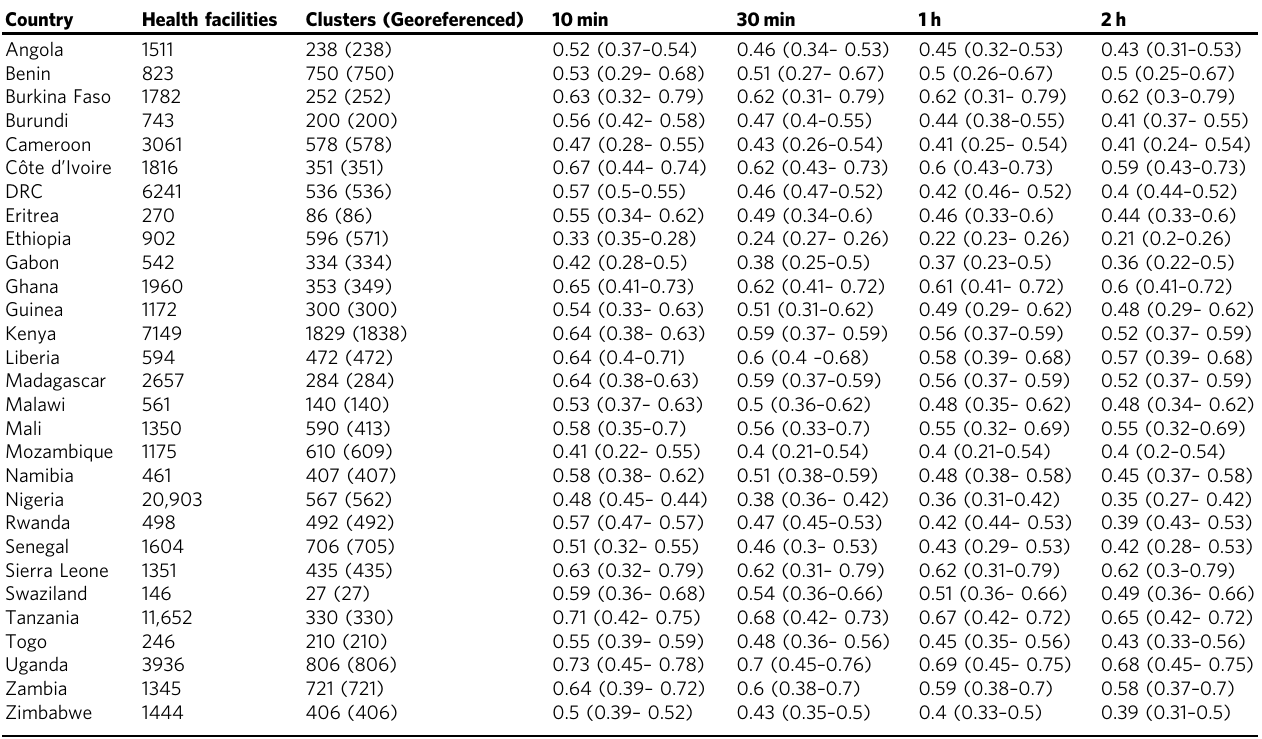
Table 1 National-level modelled estimates of the probability of seeking treatment for fever in the public sector (Posterior median and the 95% Bayesian credible interval) by travel time, for the shaded region in Fig. 3a, in 29 countries Country Health